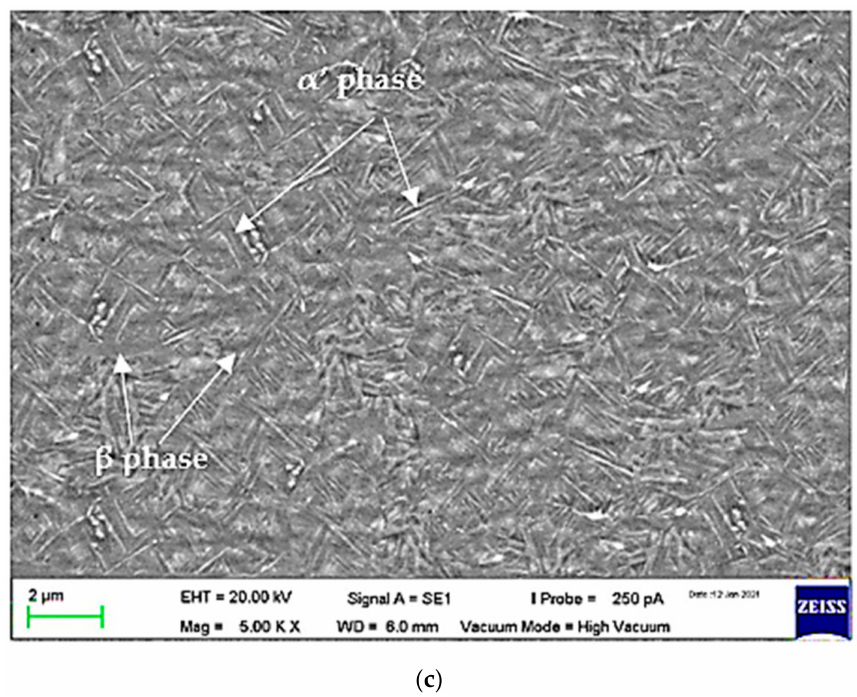
Figure 13. The sample SEM images at different positions by the confirmation test: ( a ) base metal; ( b ) heat-affected zone; ( c ) fusion zone. Magnification: 5000 × .